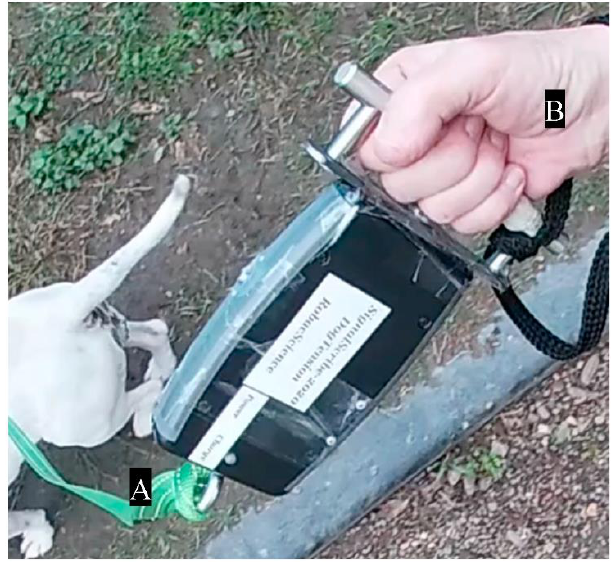
Figure 2. Close-up view of the canine leash tension meter. A l.4-metre-long leash was connected to the tension meter through the stainless-steel eyebolt ( A ) and the handler held the metal handle on the other end of the tension meter ( B ).